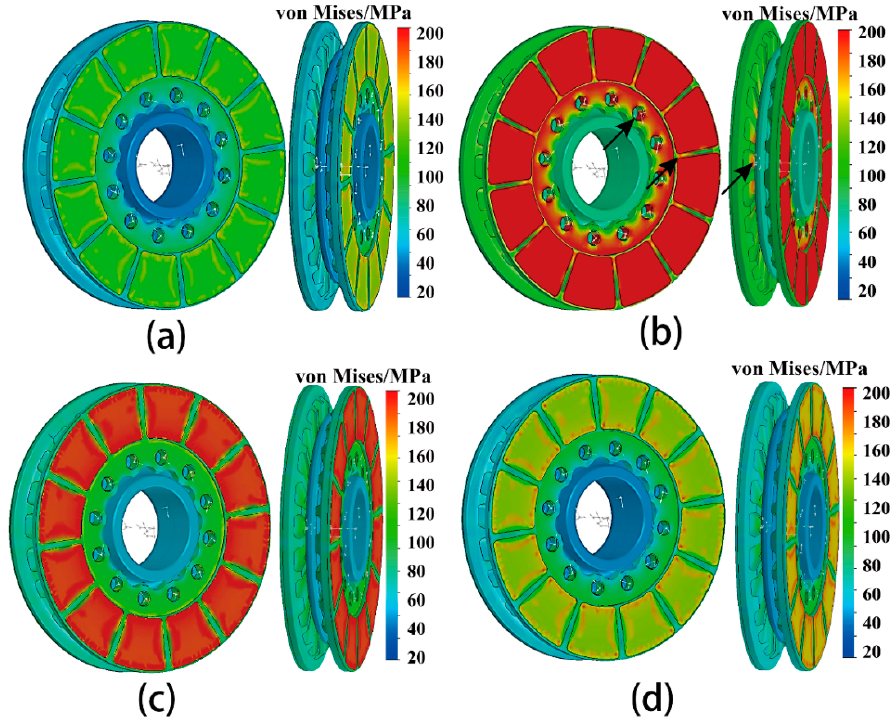
Figure 16. Stress distribution of the brake disc in the brake disc at different stages of braking operation (IBV = 97 m/s, thickness of wear-resisting layer = 4 mm): ( a )12 s; ( b ) 38 s; ( c ) 46 s; ( d ) 83 s.